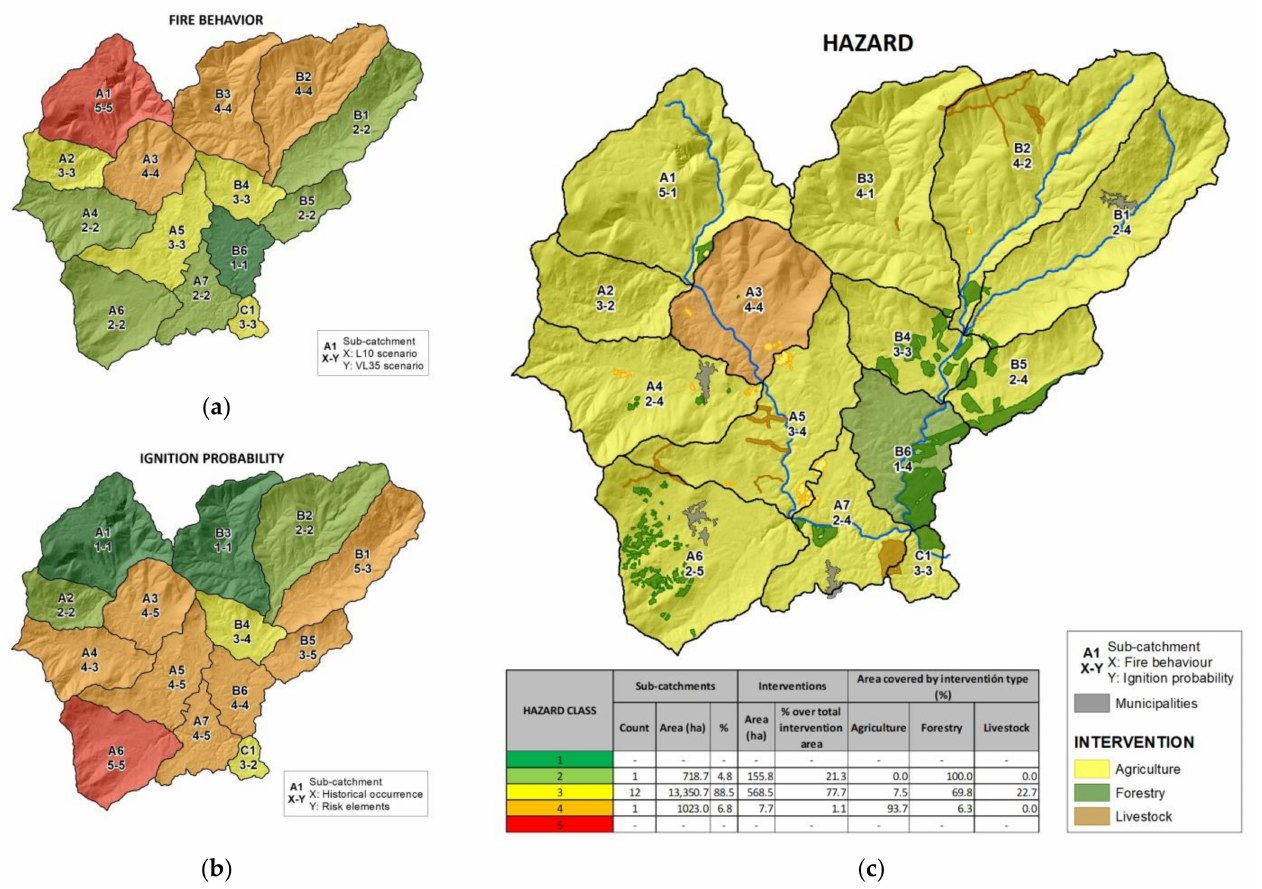
Figure 3. Hazard and its components by sub-catchment at the study site: ( a ) fire behavior; ( b ) ignition probability; ( c )